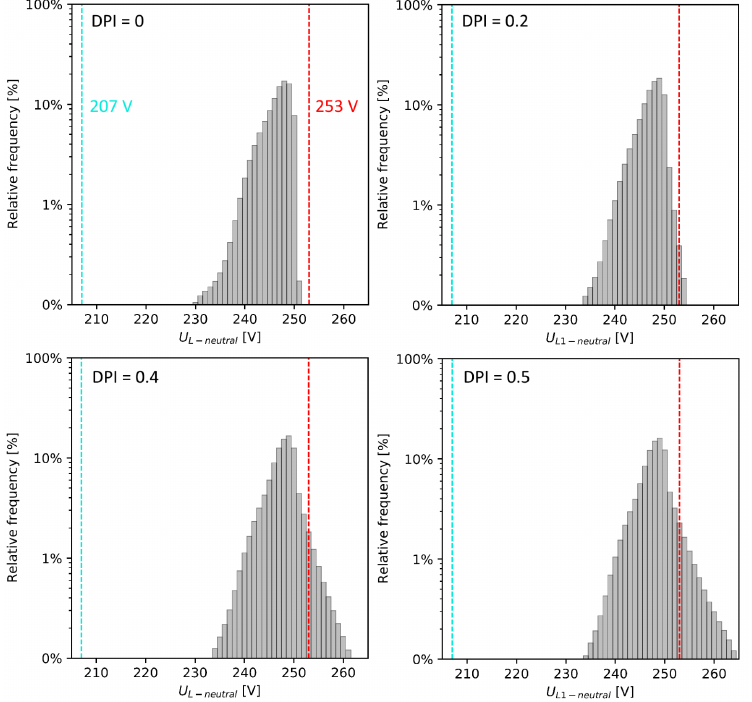
Figure 8. Histograms of voltage relative frequency in a year for different DPI. Changes in overvoltage probability (COP) for different VR were used as a global stabilization parameter. The COP calculated for DPI 0.5 is stable (absolute change between interactions was less than 0.1%) for VR larger than 60. Total COP between 60 and 100 VR is less than